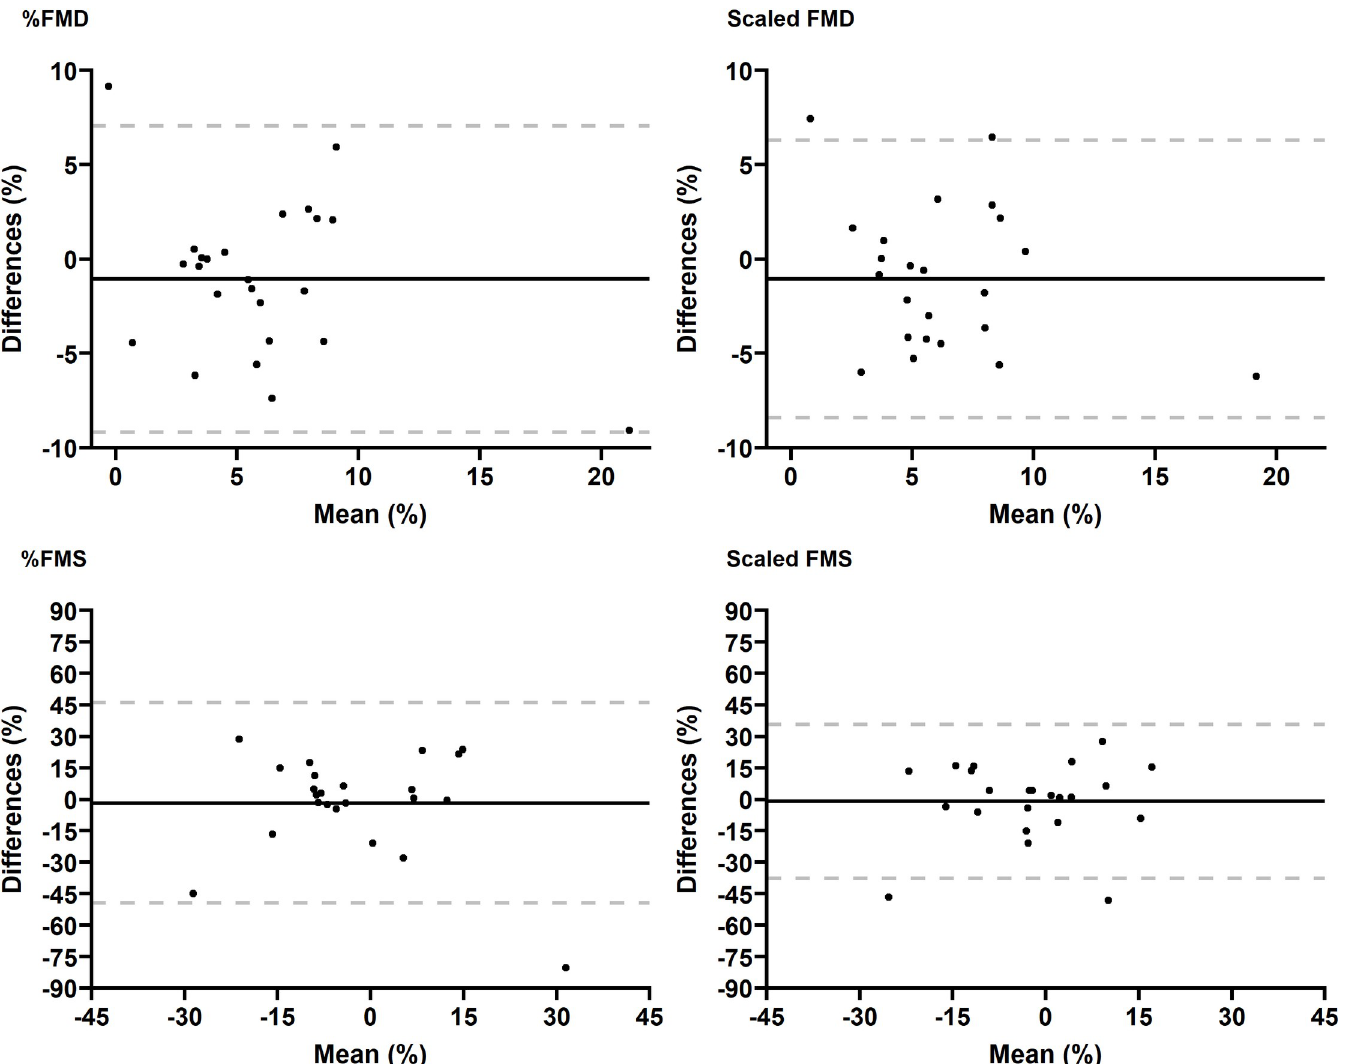
Fig 2. Bland-Altman plots for inter-day FMD and FMS measurements. Y-axis represents the difference between inter session measurements; the dashed grey lines correspond to the 95% LOA and the black line represent the mean of the differences; For %FMD, the lower 95% LOA was -9.16% (95% CI: - 12.18 to -6.14); and the upper 95% LOA was 7.04% (CI: 4.02 to 10.07); For scaled FMD, the lower 95% LOA was -8.39% (95% CI: -11.13 to -5.66); and the upper 95% LOA was 6.28% (95% CI: 3.54 to 9.01); For %FMS, the lower LOA was -49.50% (95% CI: -67.33 to -31.66); and the upper LOA was 46.08% (CI: 28.25 to 63.91); For scaled FMS, the lower LOA was -37.64% (CI: -51.32 to -23.96); and the upper LOA was 35.69% (95% CI: 22.01 to 49.38). FMS data were missing in 1